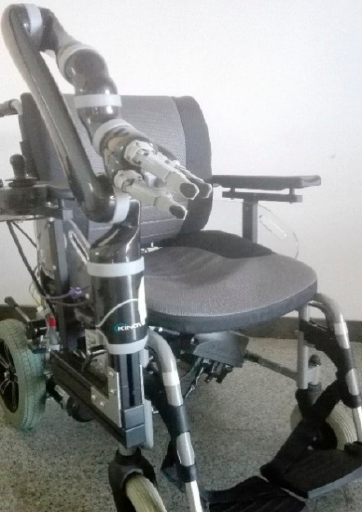
Figure 6. A physical picture of wheelchair mounted robotic arm (WMRA)